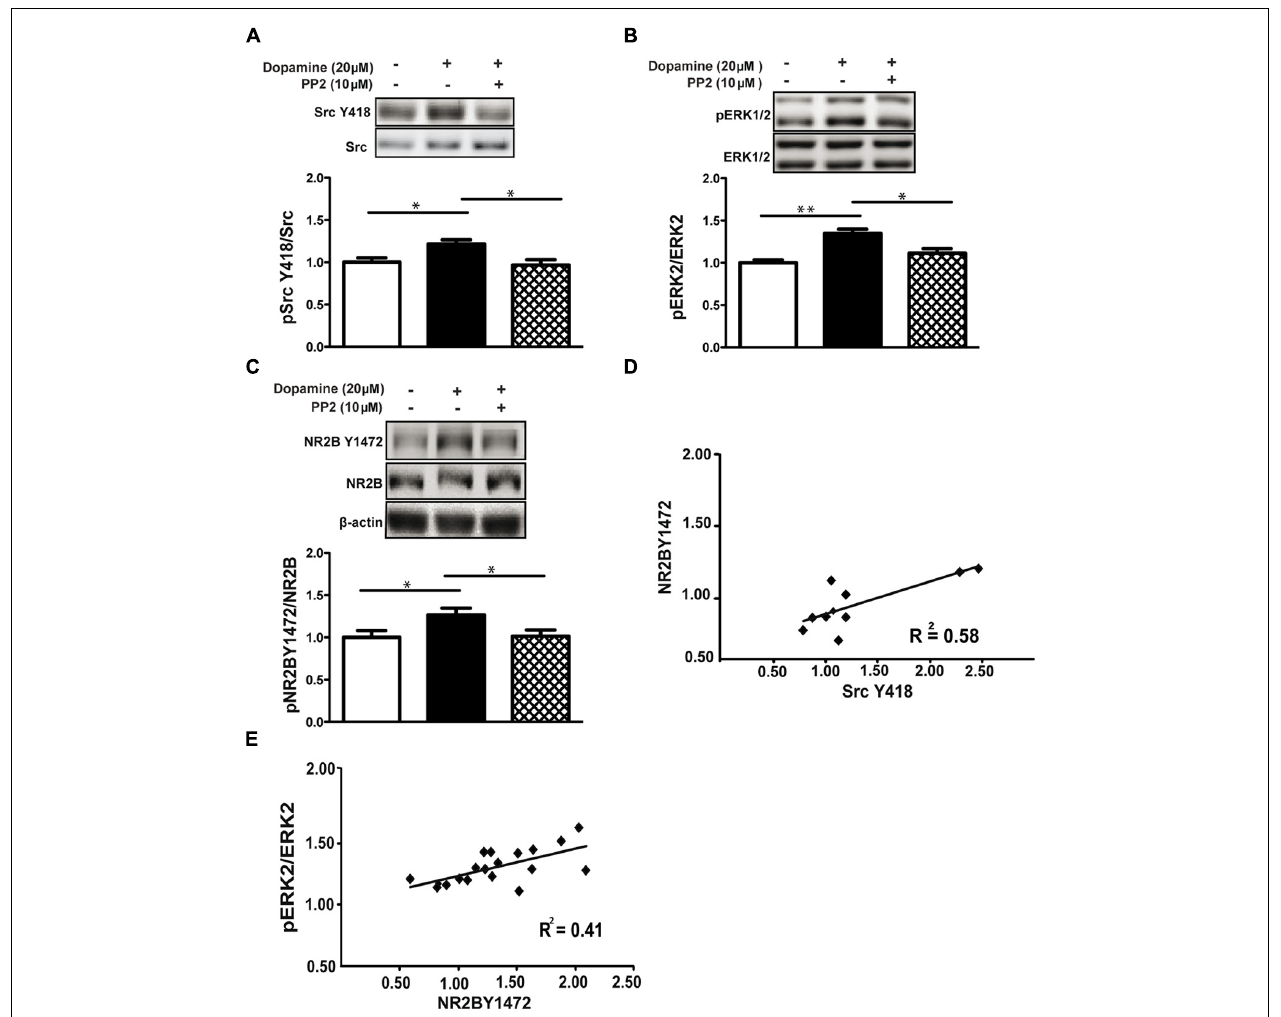
FIGURE 2 | ERK1/2 and NR2BY1472 phosphorylation by dopamine is Src family kinase-dependent. (A) Dopamine (20 μ M, 10 min) increases Tyr-418-Src family kinases (pSFKs) phosphorylation in rat hippocampal slices (* p < 0.05), and the SFK inhibitor, PP2 (10 μ M), blocks this effect (* p < 0.05 vs. dopamine, n = 16). (B) Dopamine induces phosphorylation of ERK1/2 (** p < 0.01).This induction is blocked by PP2 ( n = 16, * p < 0.05 vs.